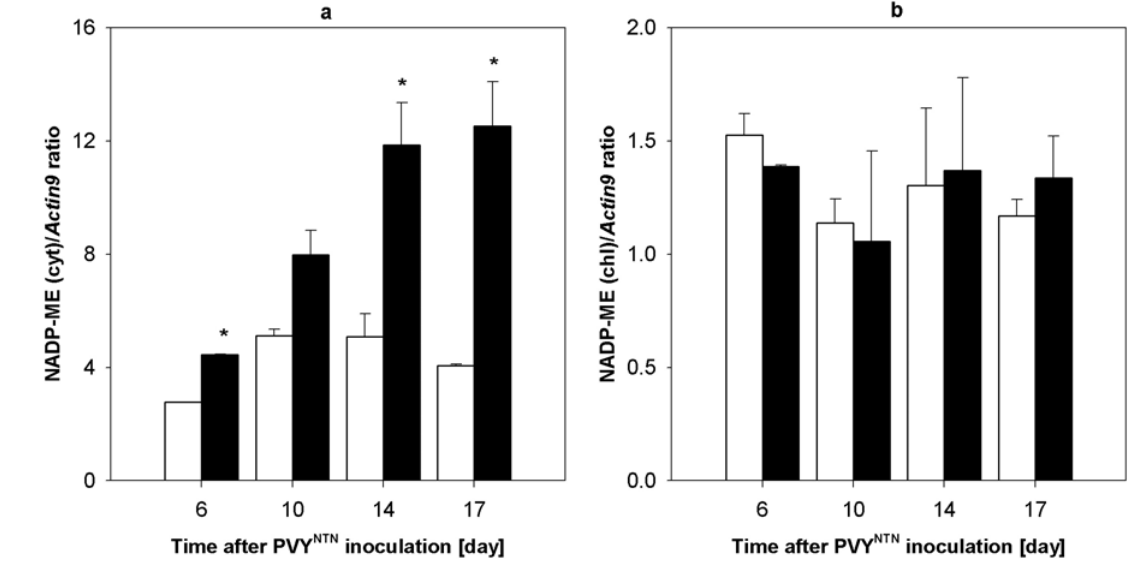
cytosolic and (b) chloroplast NADP-ME mRNA in PVY NTN infected Nicotiana tabacum L. leaves (black columns) compared to healthy control (white columns) leaves measured by reverse transcription followed by real-time PCR method 6 th – 17 th day of viral infection. transcript (b) and standard gene Actin9